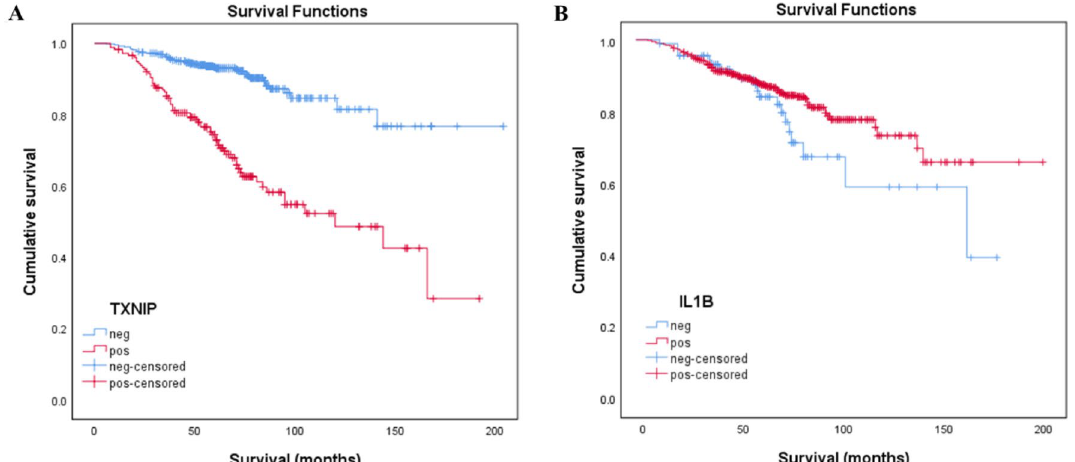
Figure 3. Kaplan–Meier estimates for disease free survival for 691 patients without metastatic disease at the time of operation. ( A ) Positive cytoplasmic immunostaining of TXNIP protein indicates its prognostic value ( p < 0.001). ( B ) Although, cytoplasmic positivity of IL1β indicates a better outcome of the disease, it is not significant ( p =